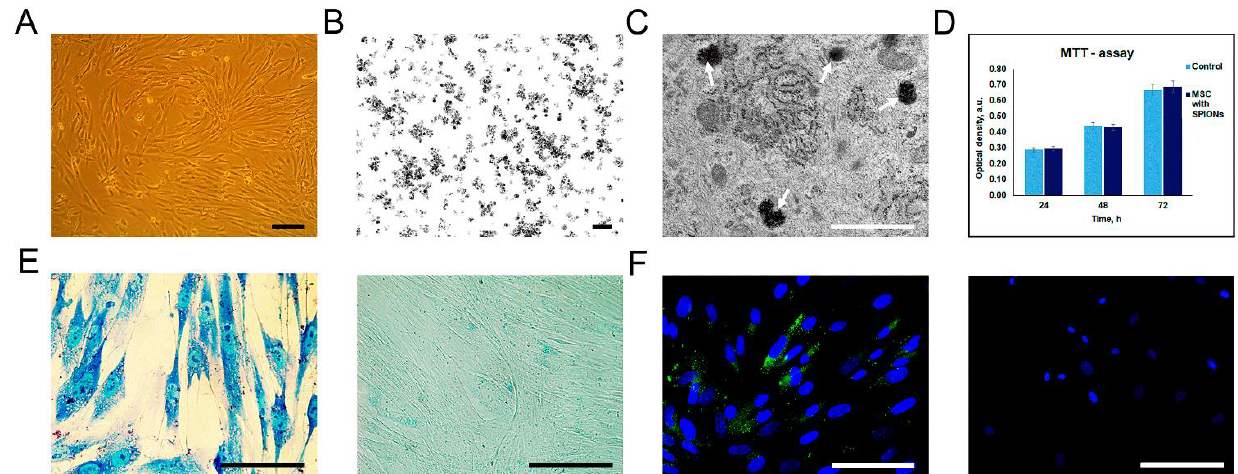
Figure 1. Assessment of nanoparticles internalization by rat mesenchymal stem cells (MSCs). ( A ) Live cell imaging. Scale bar, 100 μm. ( B , C ) TEM image of the SPIONs accumulated in the MSCs. White arrows point to secondary endosomes filled with heterogeneous material, including electron-dense nanoparticles. Scale bars: ( B , C ) 100 nm and 1 μm, respectively. ( D ) The influence of the SPIONs on the viability of cells, MTT data. ( E ) Prussian blue staining of the SPION-loaded MCSs and control (non-treated cells), respectively. ( F ) Confocal microscopy images of rat MSCs co-incubated with SPIONs and control (non-treated cells), respectively. Nuclei were stained with DAPI (blue). SPIONs were detected by reflective laser scanning (green). Scale bars: ( E , F ) 50 µm.